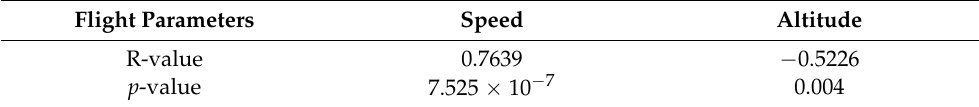
Table 1. Results of the significance test.